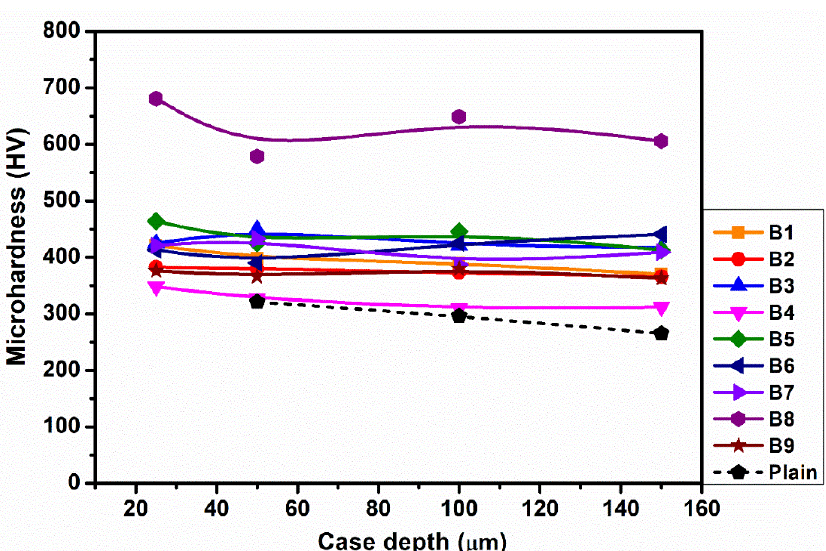
Figure 7. Microhardness profile of transverse sections of impregnated and plain EN 31 specimen B type pins, i.e., at 1040 °C.